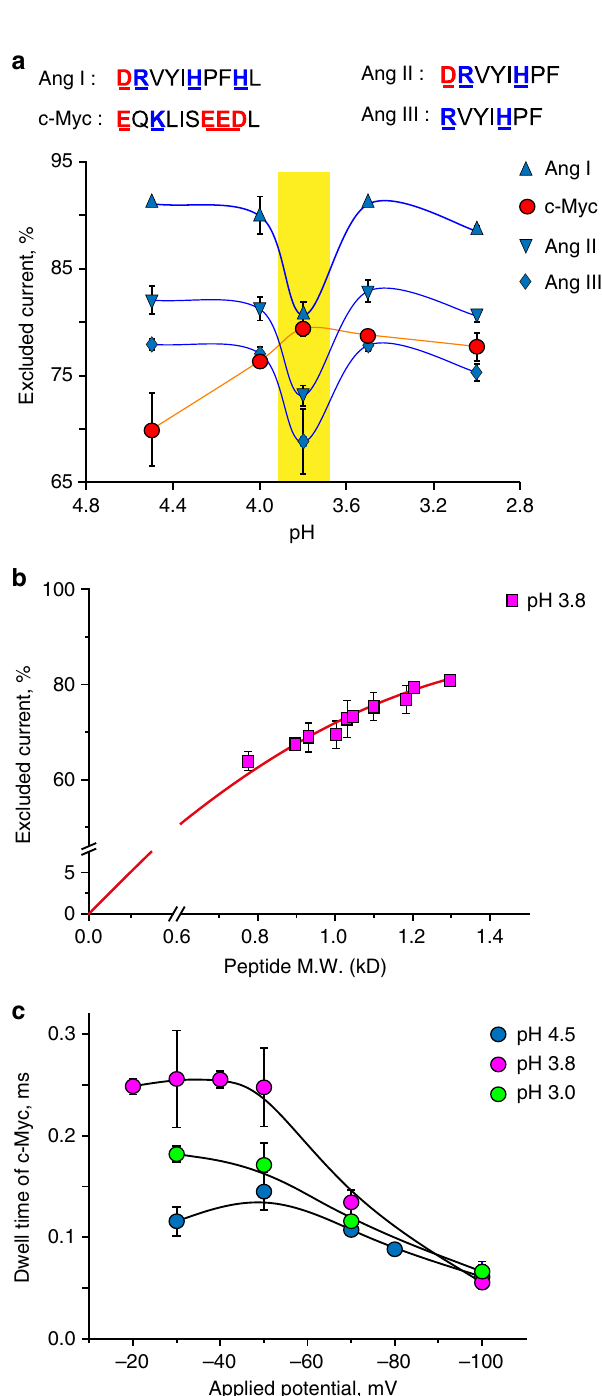
Fig. 5 A nanopore peptide mass identi fi er. a Top, sequence of the four peptides tested. The amino acids that have a positive charge are in blue and the acidic residues in red. Below, pH dependence of the I ex% for the four peptides ( cis ) using type II W116S-fragaceatoxin C (FraC) nanopores under – 30 mV applied potential. b Relationship between the I ex% and the mass of peptides at pH 3.8. c Voltage dependence of c-Myc dwell times at different pHs. All electrophysiology measurements were carried out in 1 M KCl, 0.1 M citric acid. The charges of the peptides were calculated according to the p K a for individual amino acids 53